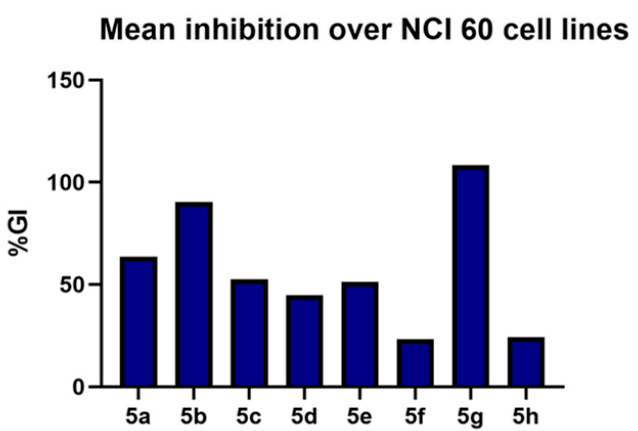
Figure 2. Graphical representation of the mean inhibition percentages calculated according to GI% values over NCI-60 cell lines.